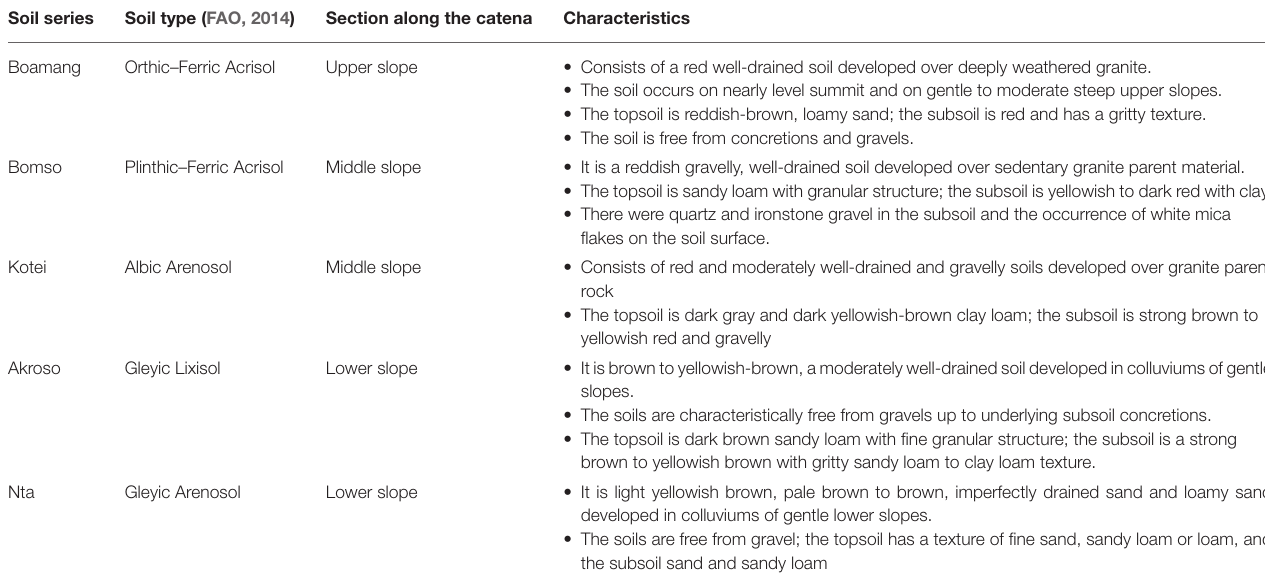
TABLE 1 | Characteristics of identified soil types in the study area. Soil series Soil type (FAO,